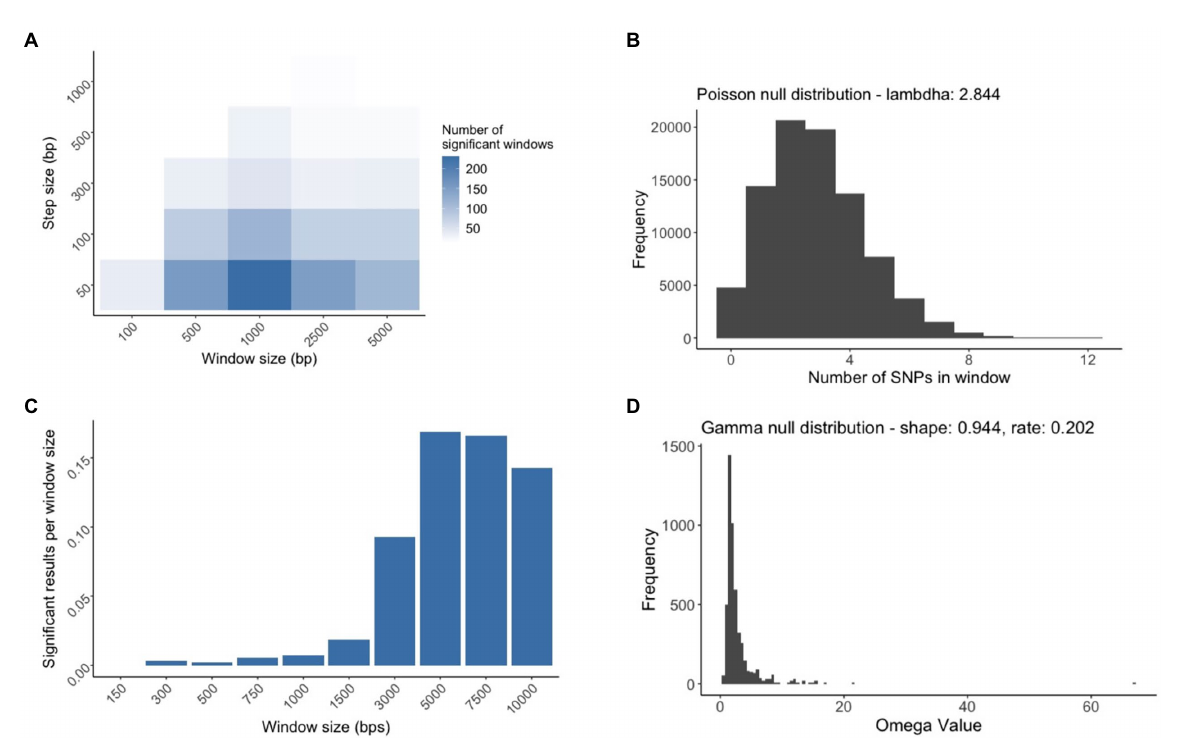
FIGURE 4 The process of creating the null distributions used for SNP Dense Regions (SDRs) and Selective Sweep Regions identification (SSRs). (A) Multiple sliding window analyses were conducted to find the window size and step size whose combination maximized the number of significant windows. The white to blue gradient represent the indicated increased number of significant results. (B) The genome wide hypothesis test for SDRs relied on a window size of 1,000 bp and a step size of 50 bp to generate a Poisson null distribution for subsequent tests. (C) Multiple selective sweep analyses were conducted by varying the window size to find the size that maximized the number of significant results normalized by the window length. (D) The genome wide hypothesis test for SSRs relied on the window size of 5,000 bp to generate a Gamma null distribution for subsequent